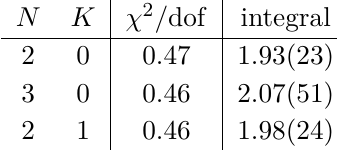
Table 12 . Results for the integral on the l.h.s. of (4.20) obtained for the fits with ( N, K ) = (2 , 0) , (3 , 0) , (2 , 1) . In the center column we again list the values of χ 2 / dof for the